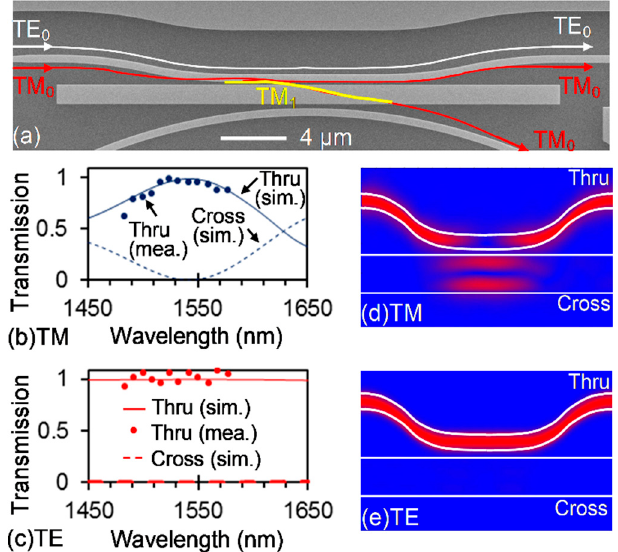
Figure 3. The fabricated multimode waveguide-based PBS. ( a ) SEM image. Simulated and measured spectra for TM ( b ) and TE ( c ) modes when the coupling length is 10.74 µm. Simulated light propagation at 1550 nm when the PBS is operating on TM ( d ) and TE ( e ) modes.